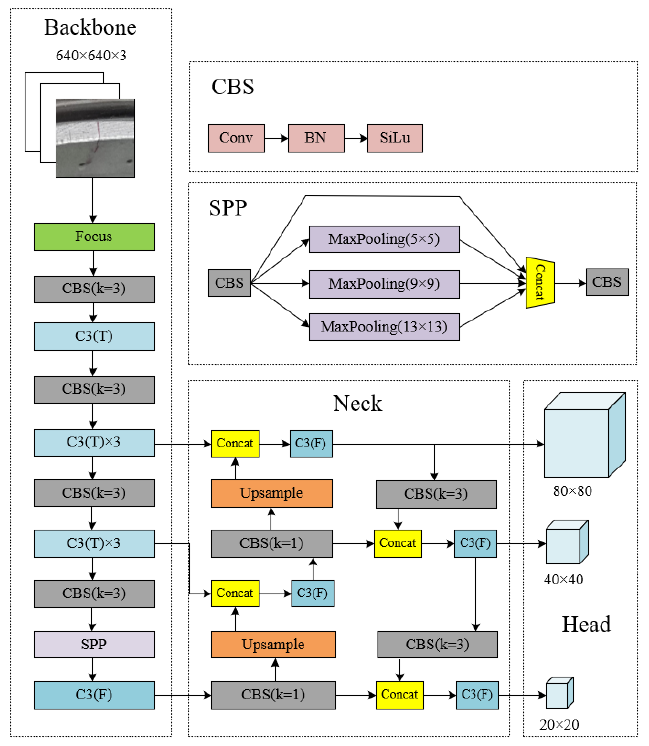
Figure 1. The architecture of YOLOv5s.